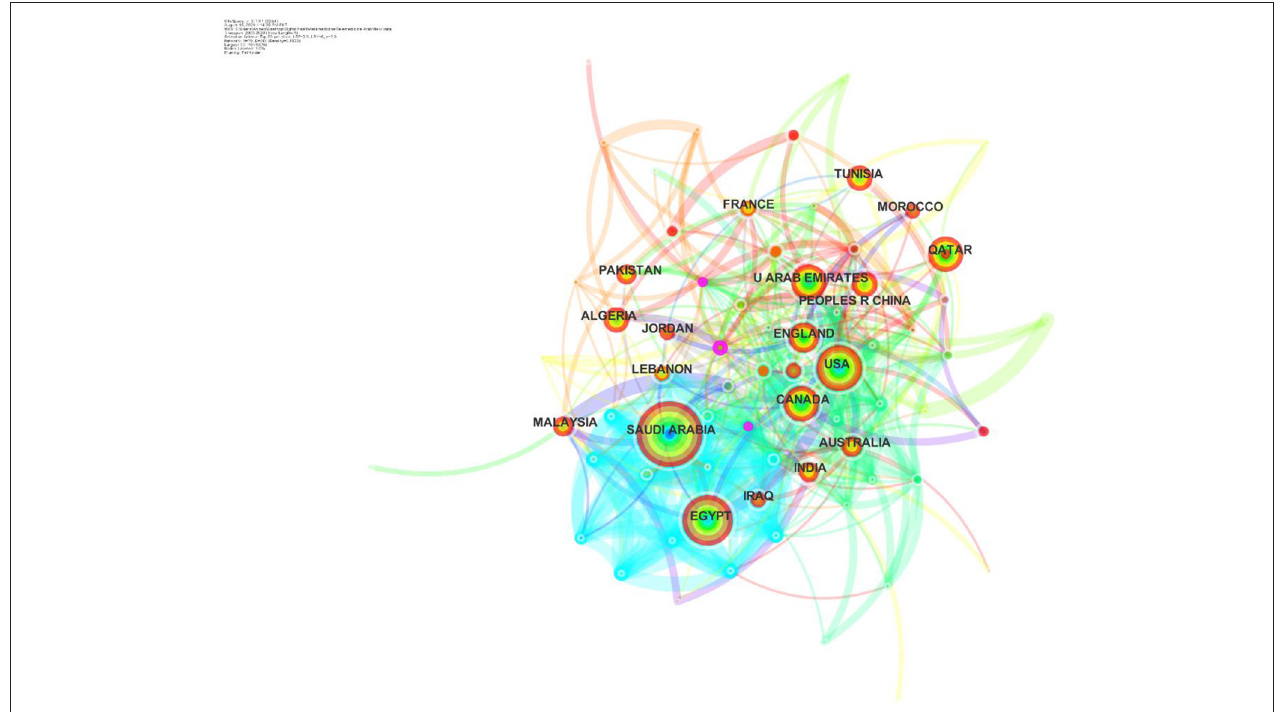
FIGURE 3 | Central countries in the area of digital health in the Arab world.